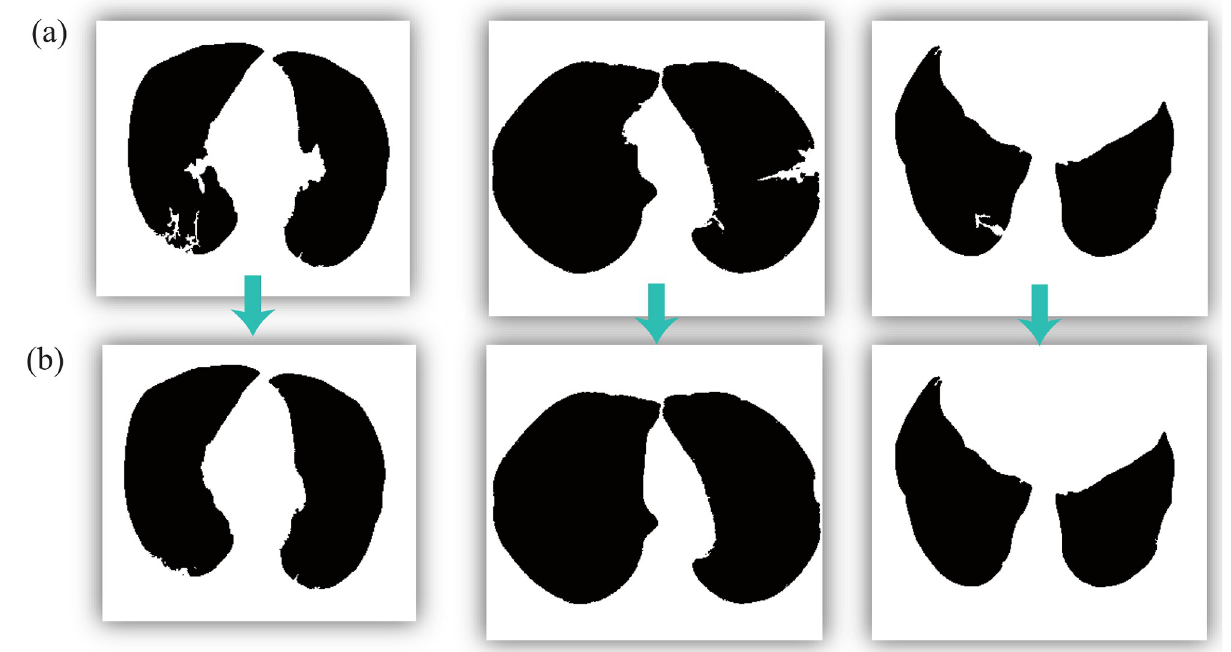
Fig 12. Binary image correction effect. (a) Initial lung regions and (b) corrected lung images.